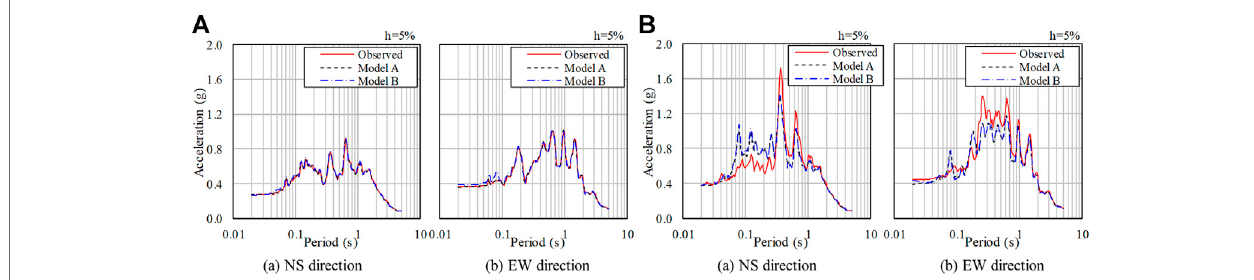
FIGURE 9 | Comparison of acceleration response spectra at (A) 7-R2 on B3F and (B) 7-R1 on 3F.